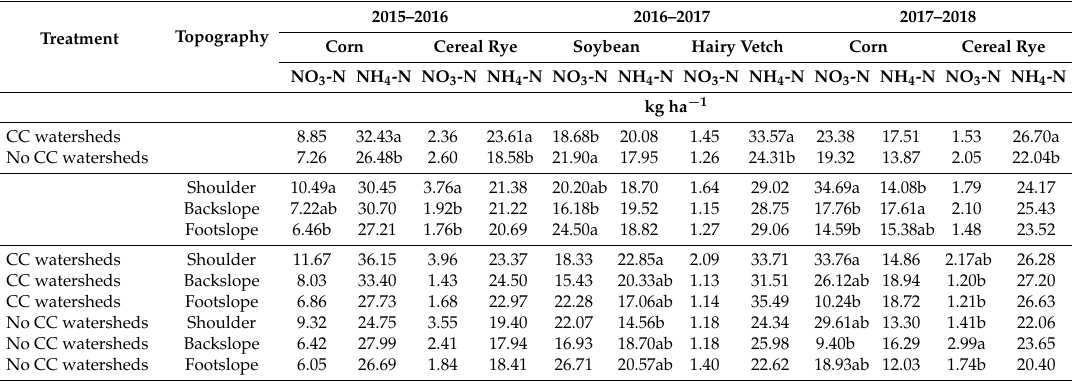
Table 6. Soil nitrate-N (NO 3 -N) and ammonium-N (NH 4 -N) in cover crop (CC) watersheds with topography being summed over two depths (0–15 and 15–30 cm). Within a column and within a given factor or combination of factors, means followed by the same letter are not statistically different ( α =